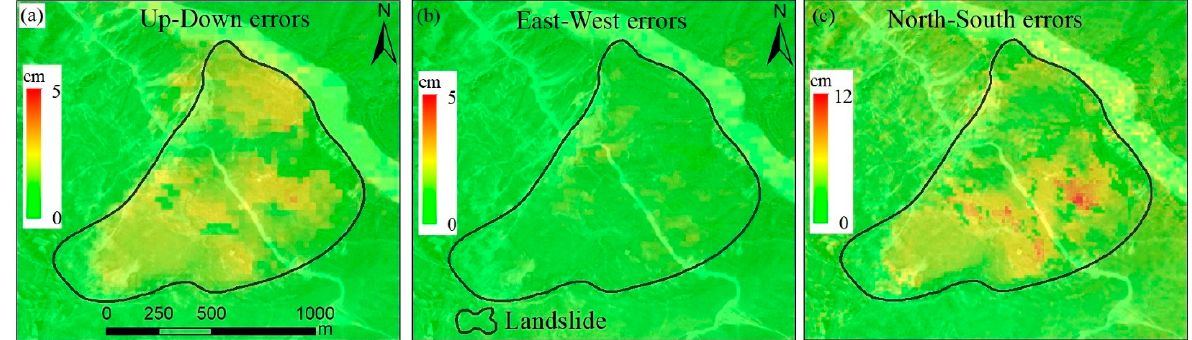
Figure 9. Error analysis of three-dimensional decomposition. ( a – c ) The deformation errors (cm) of the vertical, east-west and north-south directions.